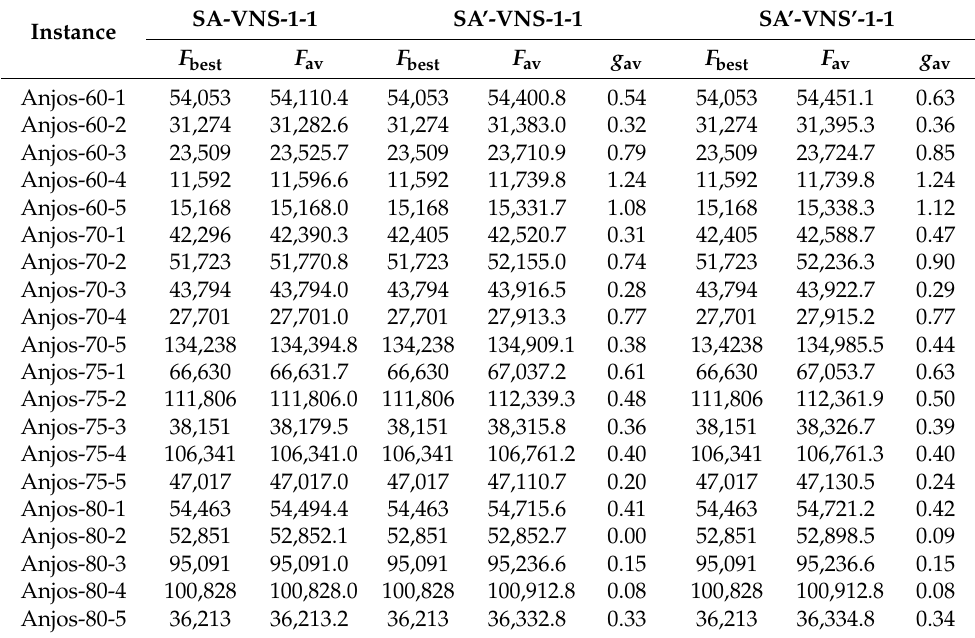
Table 9. Comparison of different SA-VNS-1-1 versions for the Anjos instances of the tool index- ing problem.